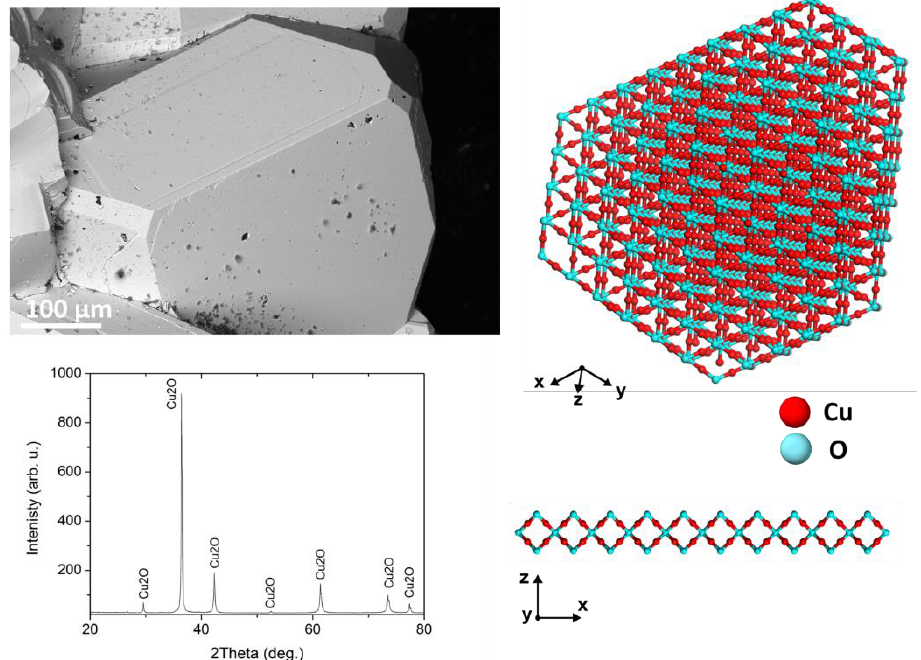
Figure 1. SEM micrograph of the bulk Cu 2 O crystal ( top left ), XRD pattern of the powdered sample with visible reflections identified as the Cu 2 O phase (bottom left), and the crystal structure models of the bulk Cu 2 O crystal ( top right ) and theoretical monolayered Cu 2 O ( bottom right ).